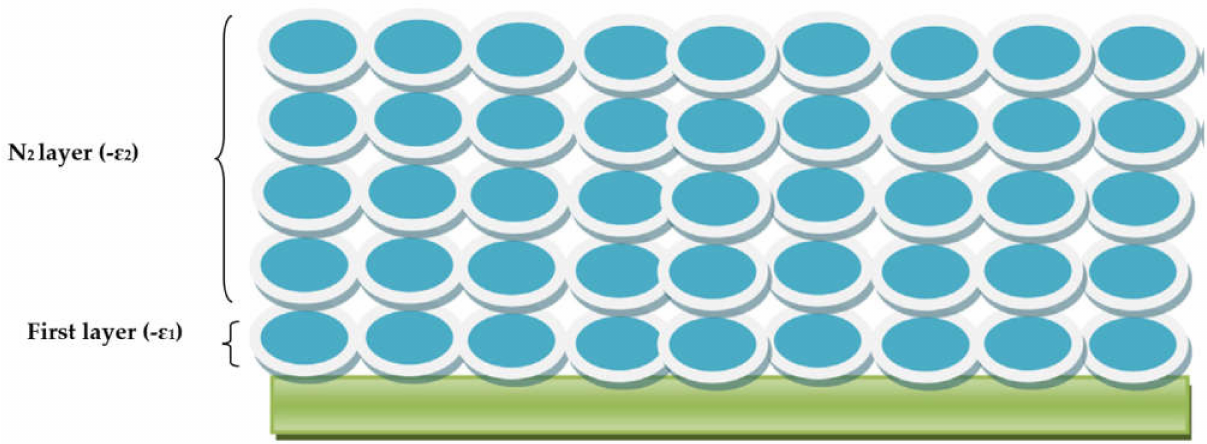
Figure 3. Schematic illustration of the distribution of the molecules adsorbed on a solid according to the multilayer model with saturation.